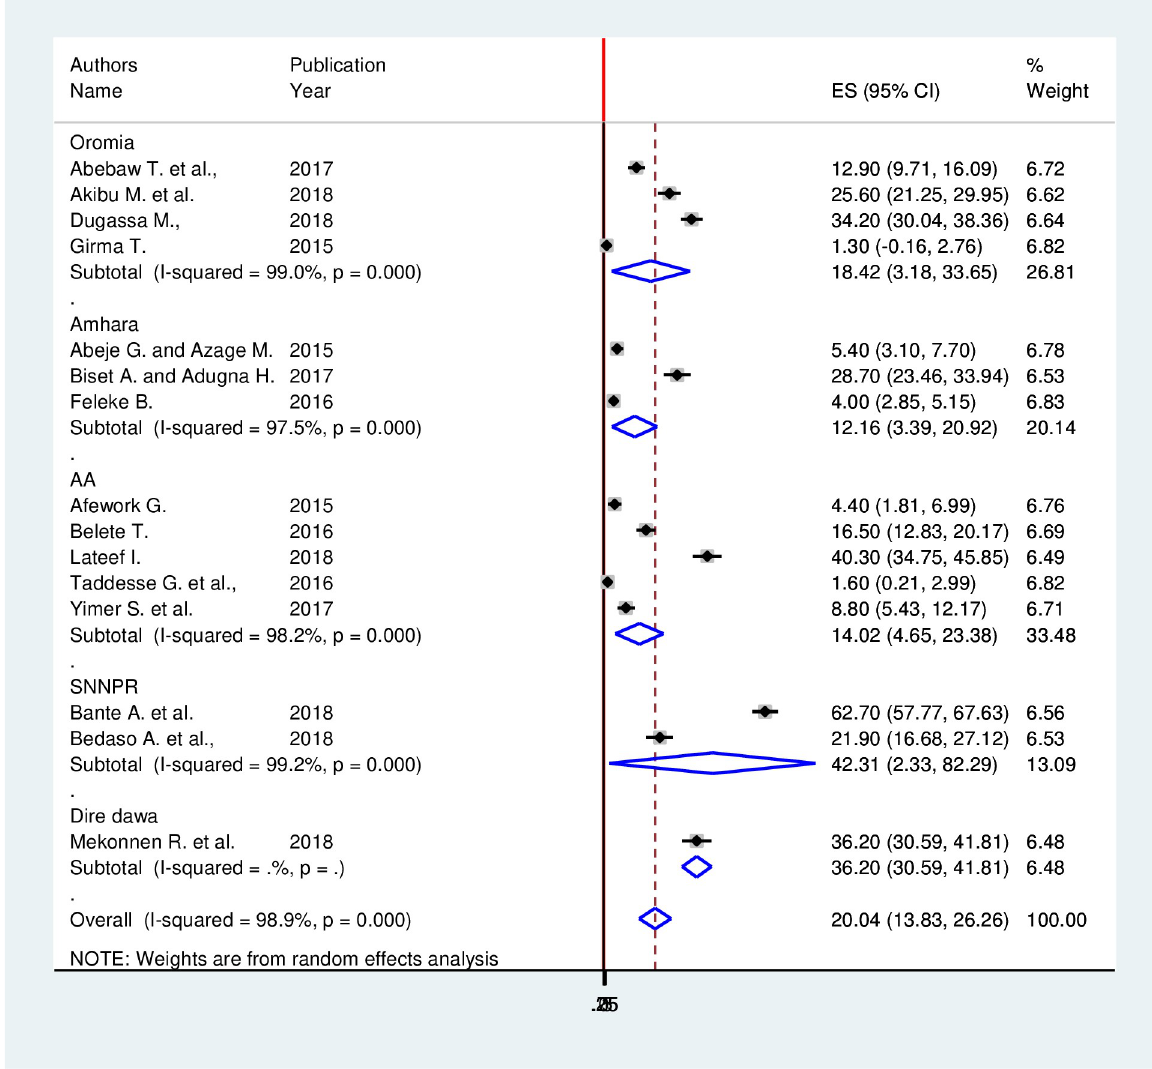
Fig 3. Subgroup analysis of full-dose hepatitis B vaccination coverage among health care providers by region in Ethiopia.